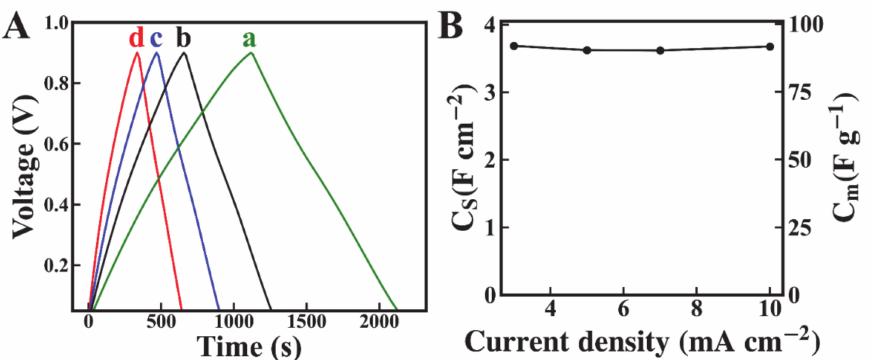
Figure 6. ( A ) Charge discharge behavior at current densities of (a) 3, (b) 5, (c) 7, and (d) 10 mA cm − 2 , and ( B ) capacitance versus current density for Mn 3 O 4 -MWCNT electrodes.